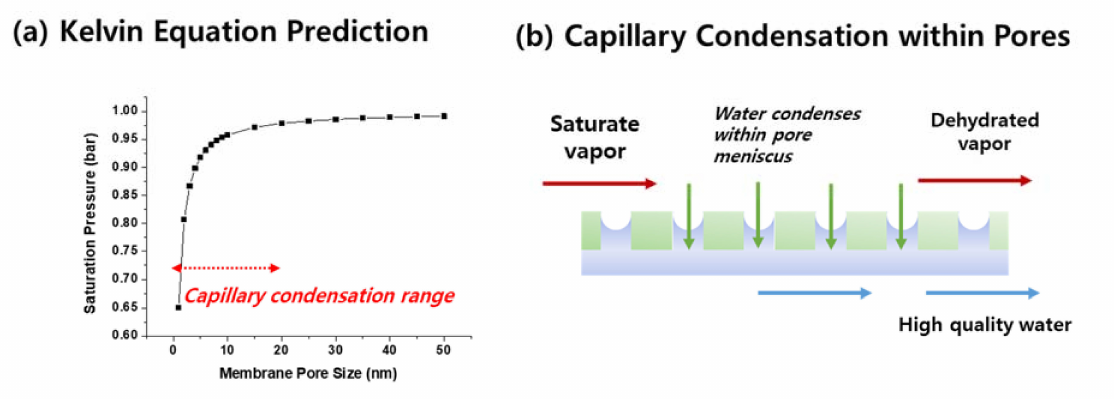
Figure 5. ( a ) Estimation of water saturation pressure at 100 ◦ C as a function of membrane pore size, ( b ) schematic illustration of capillary condensation of water vapors within membrane